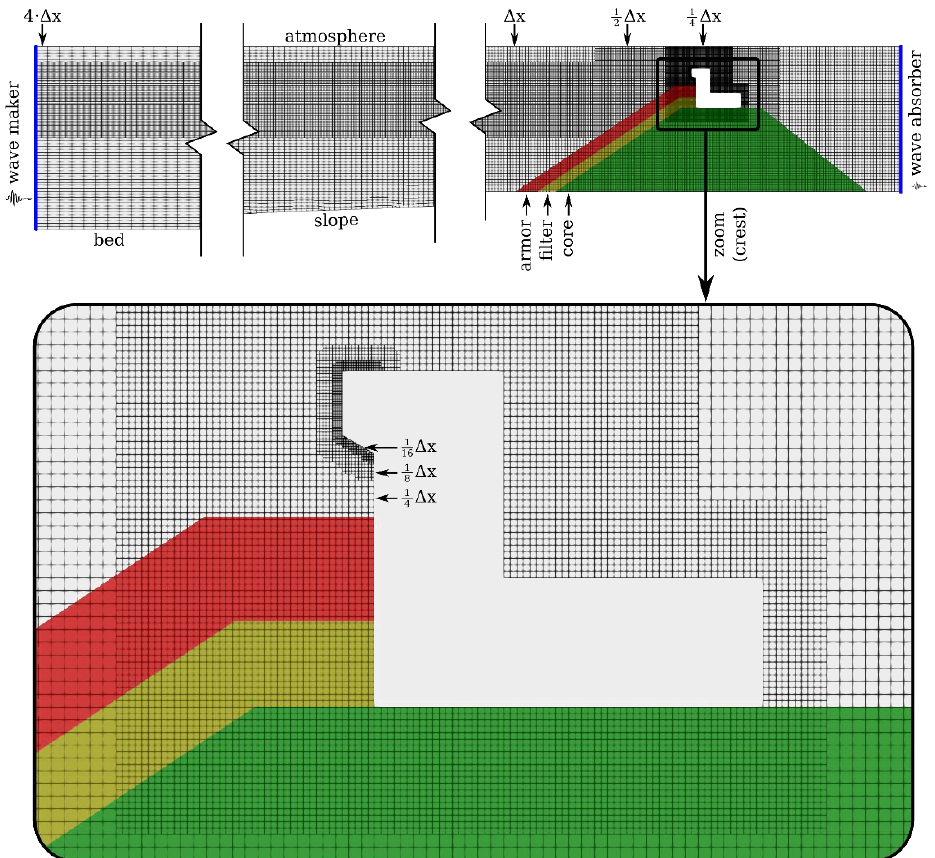
Figure 5. Mesh detail of the OpenFOAM ® model (Source: Molines et al. [1]).